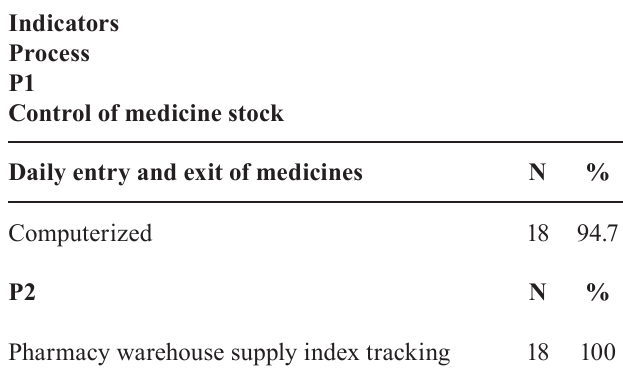
TABLE II - Process indicators (P1 and P2) of PS in PHC, in 2015 and 2016.